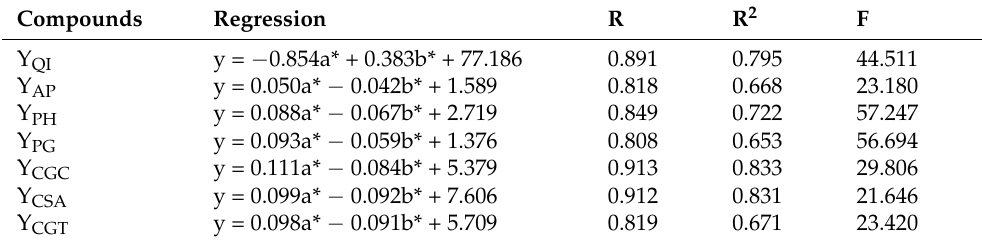
Table 4. The regression equation between color values and